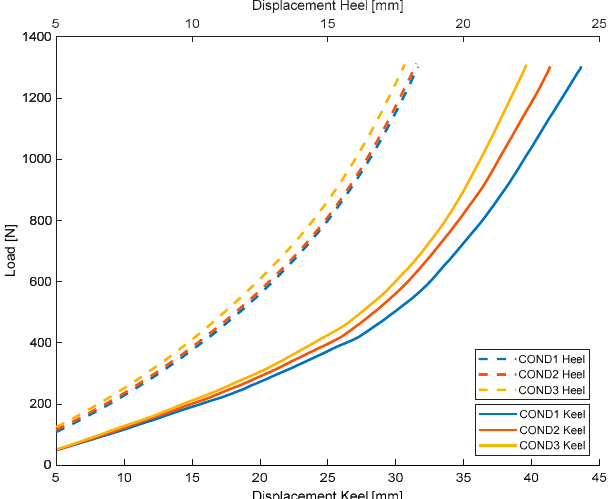
Figure 6. VSA prosthetic foot load versus displacement heel and keel stiffness test results for condi- tion 1 (softest), condition 2 (mid), and condition 3 (stiffest).